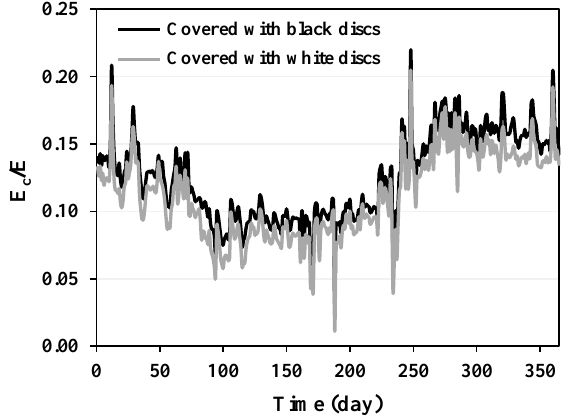
Figure 12. The ratio of evaporation from covered ( E c ) to uncov- ered water reservoirs ( E ) representing evaporation suppression ef- ficiency of floating elements (for the meteorological conditions in Majadas, Spain, from March 2004 to March